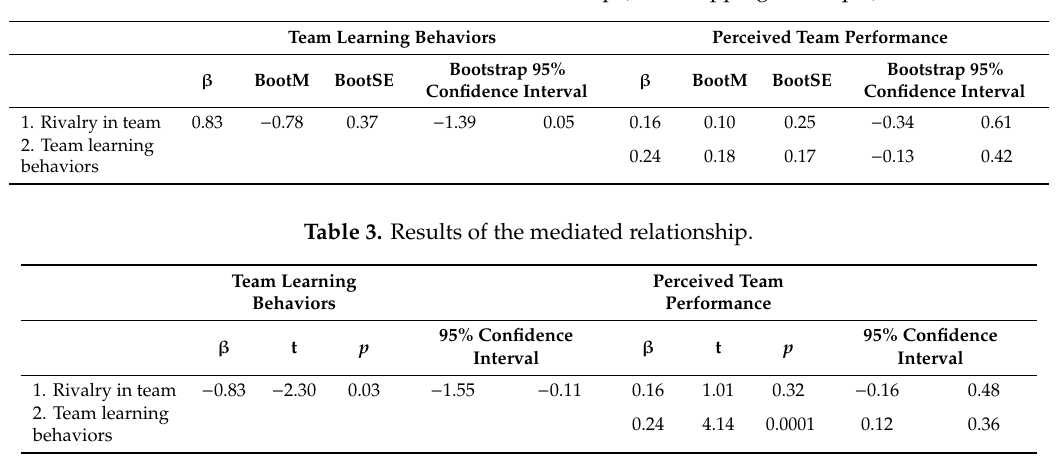
Table 2. Results of the mediated relationship (bootstrapping technique).